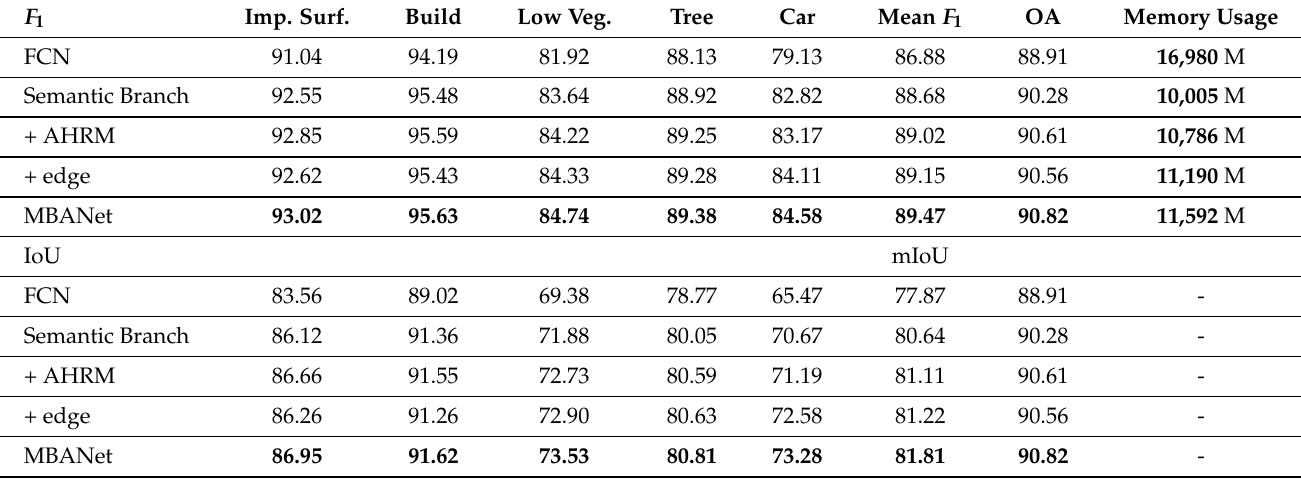
Table 8. Experimental results of the final model and memory usage on Vaihingen